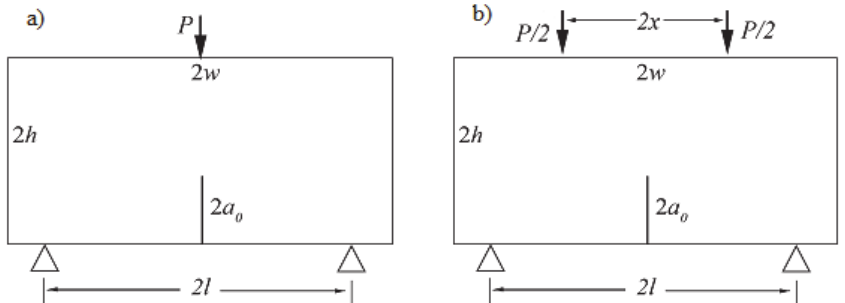
Figure 6: Geometry and loading scheme of a) 3-point bending test, b) 4-point bending